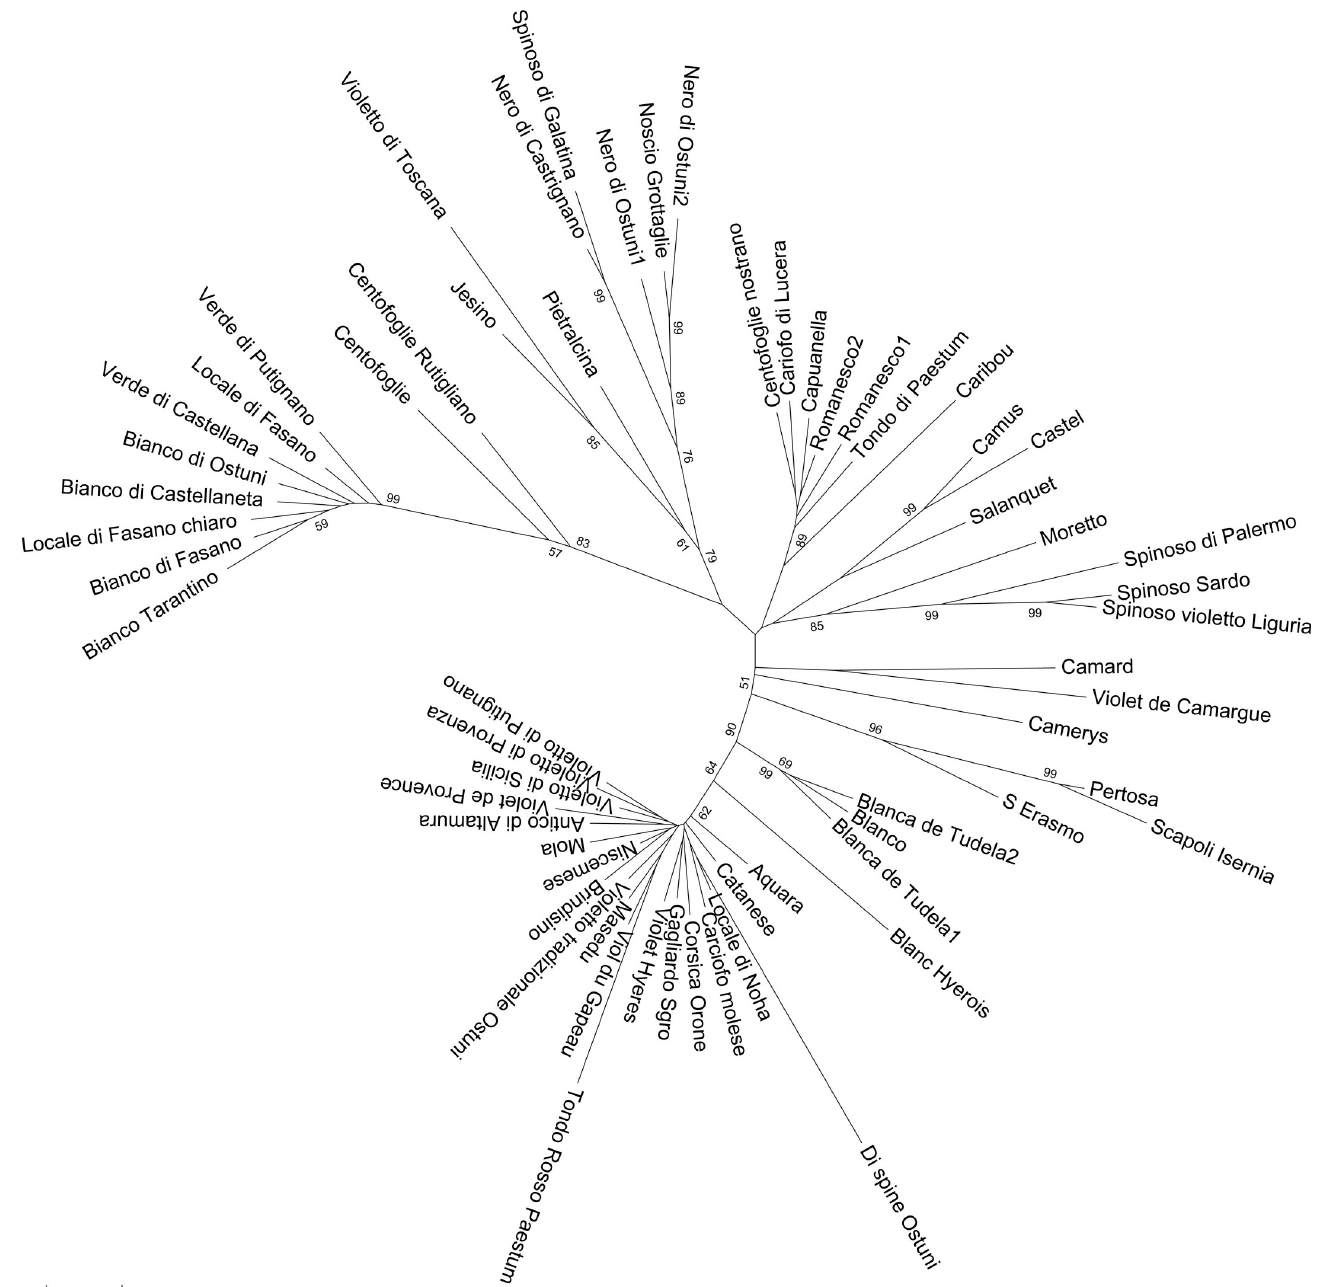
Fig 6. Neighbor-Joining tree obtained from SNP data on the globe artichoke genotypes. Number on tree branches indicate bootstrap values ( � 50).